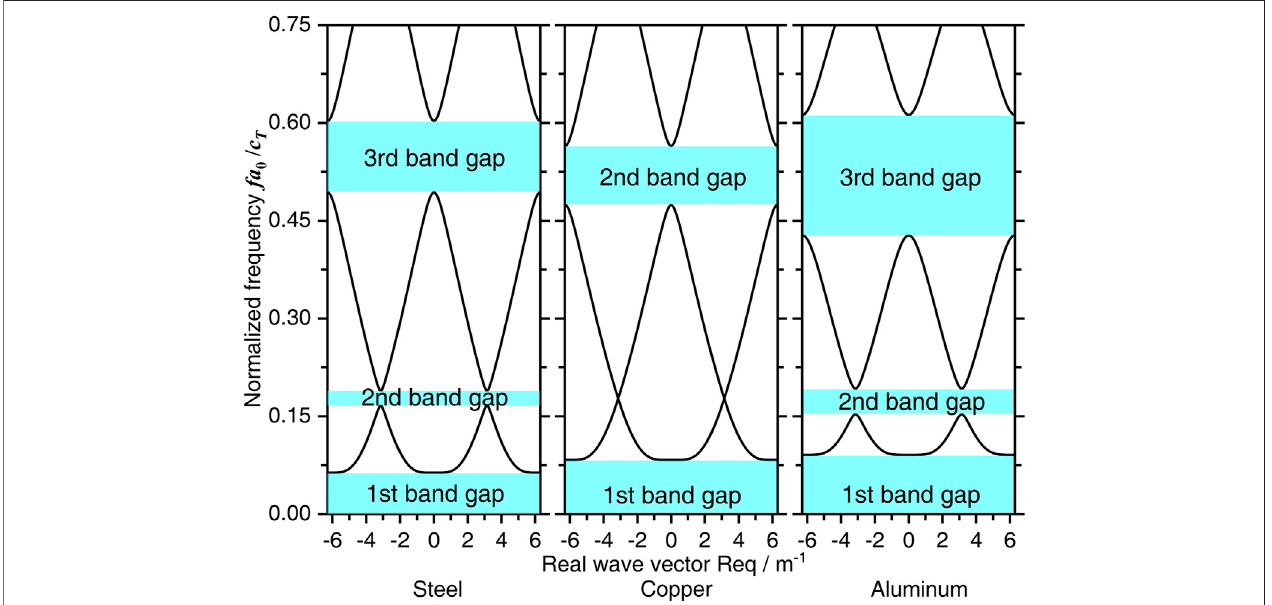
FIGURE 10 | The fl exural wave band gaps characteristics with different homogeneous beam material properties.